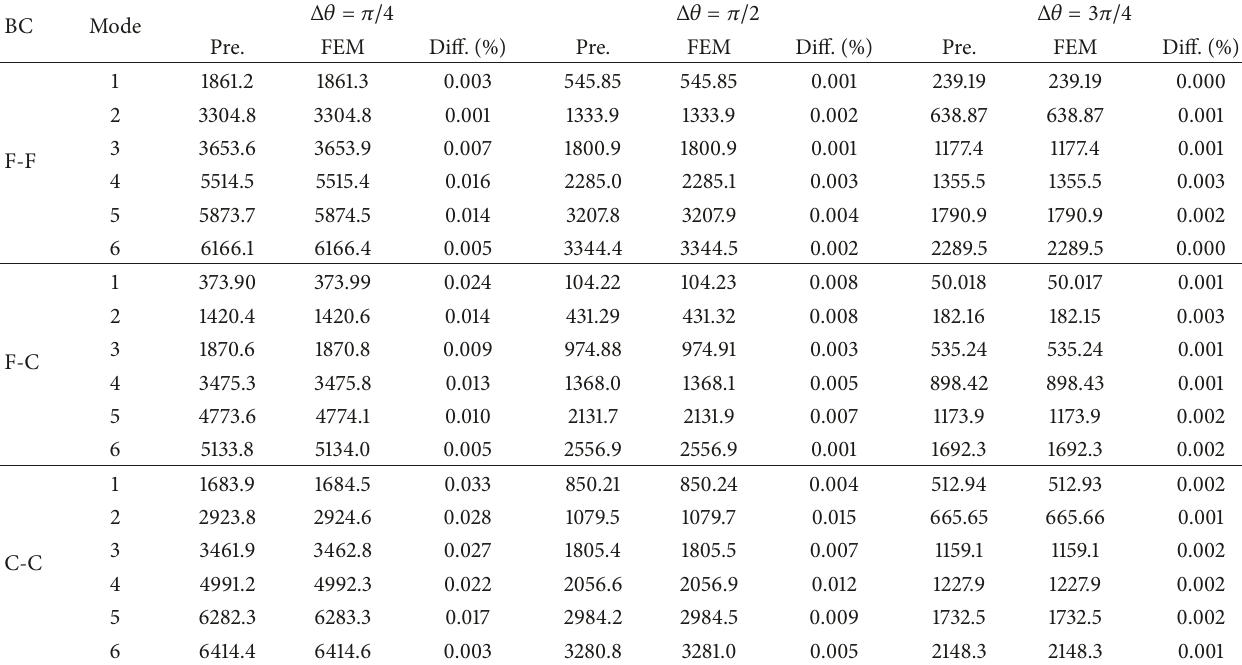
Table 3: The lowest six frequencies for circular beams with different boundary conditions, geometrical properties, and modeling methods (Hz, 𝑅 𝑚 = 1 m, ℎ/𝑅 𝑚 = 0.3 ).